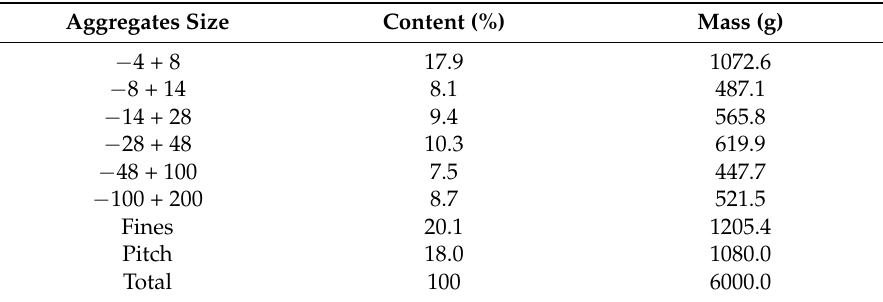
Table 1. Anode paste